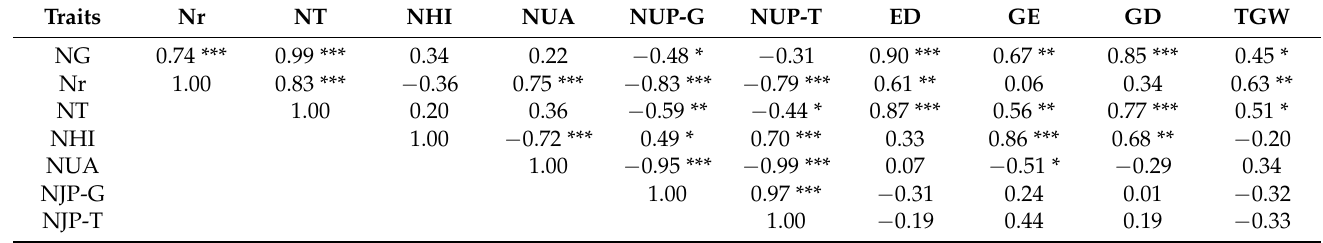
Table A2. Matrix of correlation indices for nitrogen parameters and yield components, n = 21.